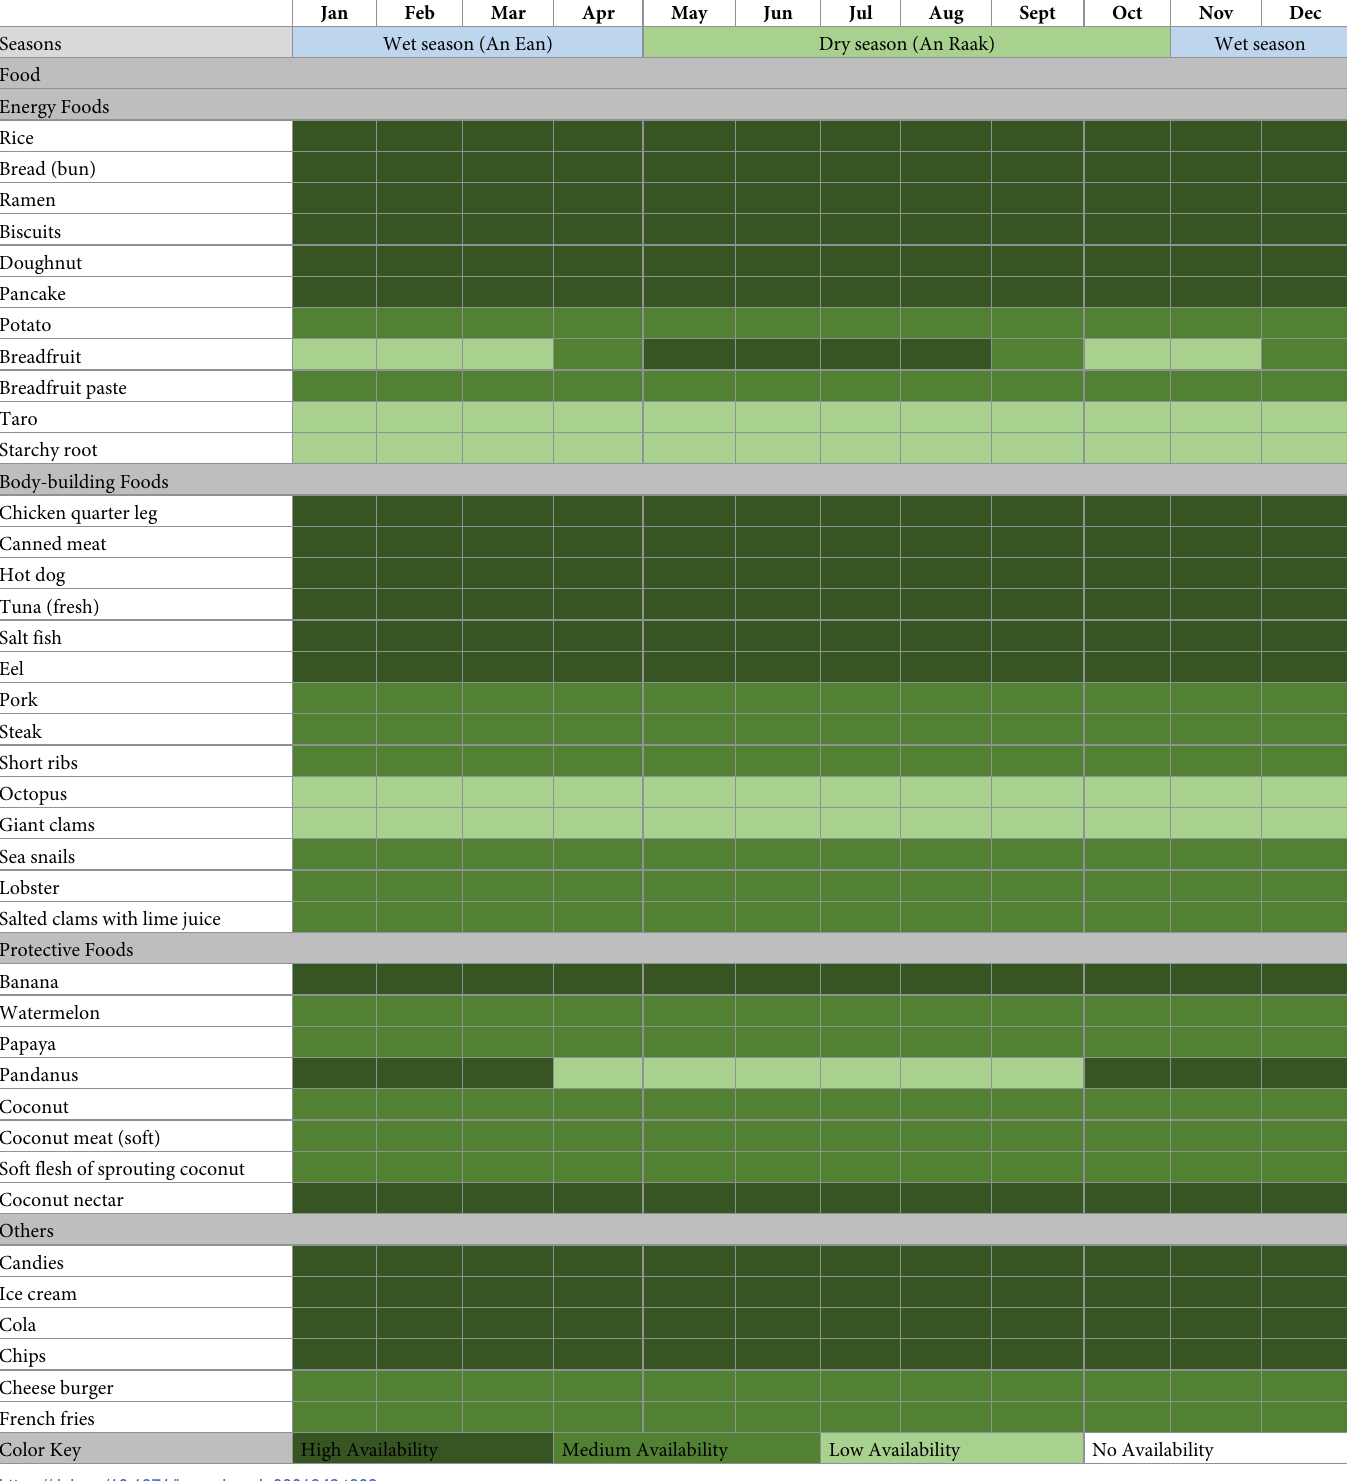
Table 2. Seasonal food availability calendar for Rita